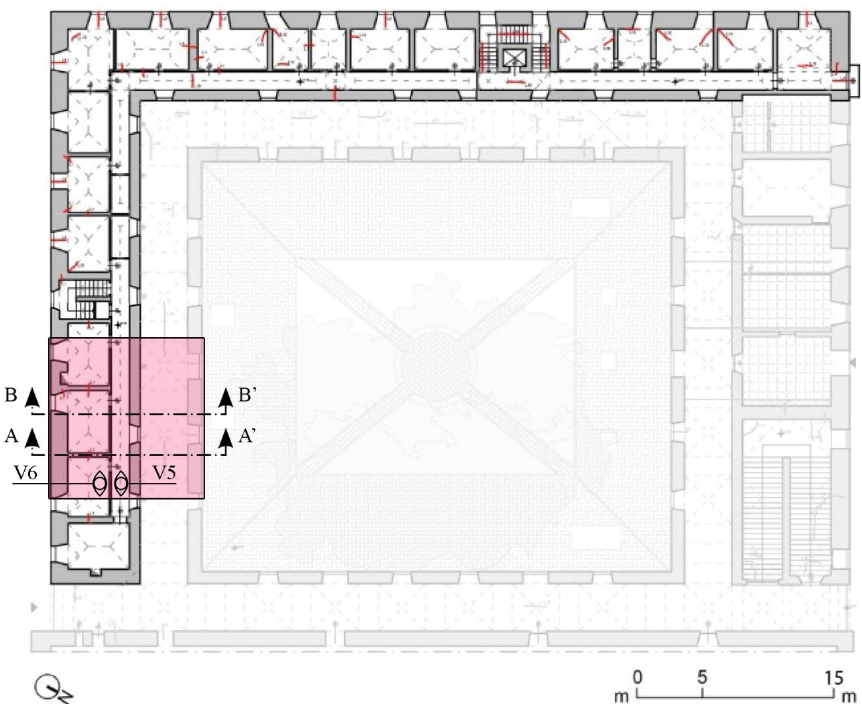
Figure 4. Survey of plan of the mezzanine floor (h = 4.7 m). In red lines, the main lesions on the vaults are reported. The span selected for the following FEM is highlighted in red. The location of the performed videoendoscopies is reported (V5, V6).